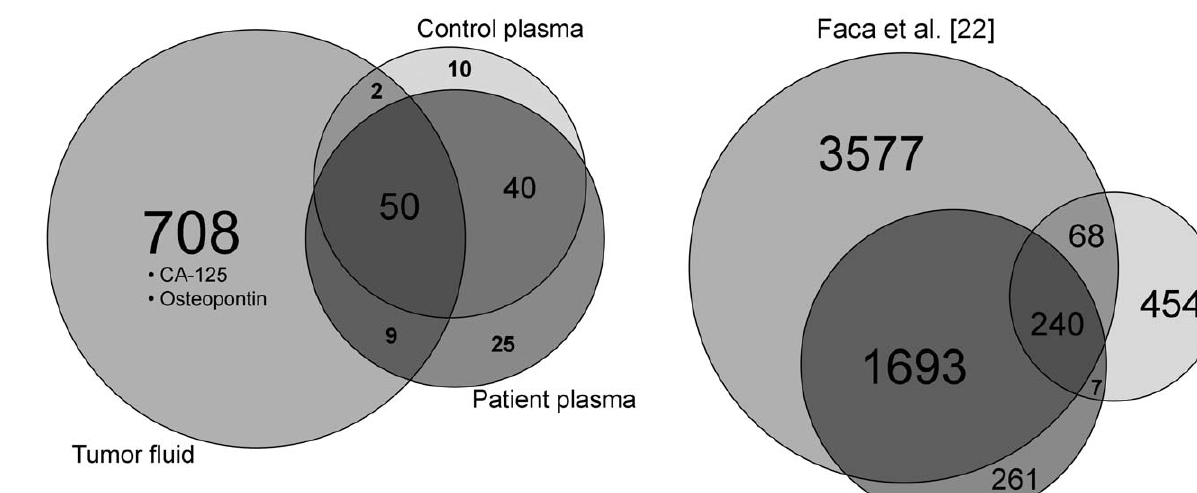
Figure 5. Overview of proteomic results for tumor fluid compared to plasma. Pooled plasma and tumor fluid samples of three patients with ovarian cancer and a control pool taken from five women operated for suspected ovarian carcinomas later shown to be benign were immunoaffinity depleted, fractionated by reversed phase and strong cation exchange chromatography at protein level and nano- reversed phase liquid chromatography at peptide level before analysis by tandem mass spectrometry. Venn-diagram of the three proteomes identified from tumor fluid (left), patient plasma (lower right) and control plasma (upper right). Analyzing patient plasma compared to control plasma yielded few new proteins, while the tumor fluid contains a large amount of proteins not detected in plasma.